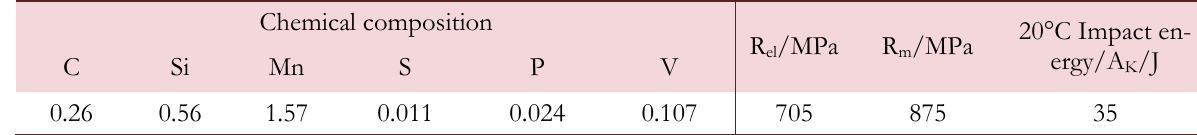
Table 1: The chemical composition and mechanical properties of the